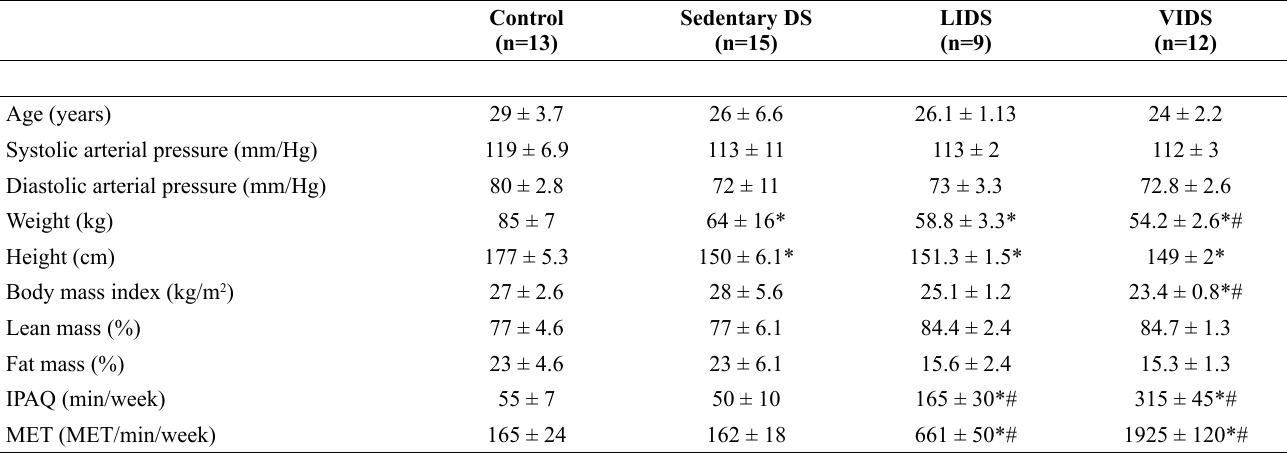
Table 1. Hemodynamics and body composition characteristics of the investigated subjects: